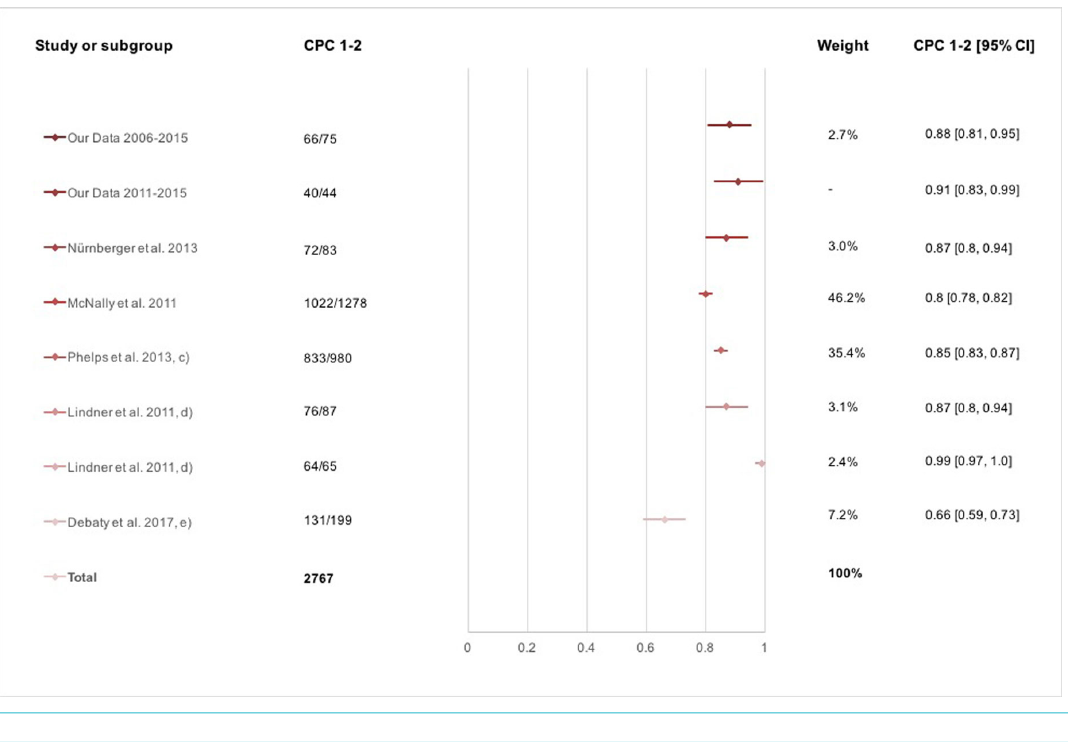
Figure 5: CPC score at hospital discharge.* Outcomes are reported according to Utstein (cardiac aetiology, witnessed [layperson or EMS] and shockable initial rhythm), if not mentioned otherwise: (c) includes non-witnessed, non-shockable; (d) includes non-witnessed; (e) includes non- cardiac, non-witnessed, non-shockable, excludes EMS-witnessed.